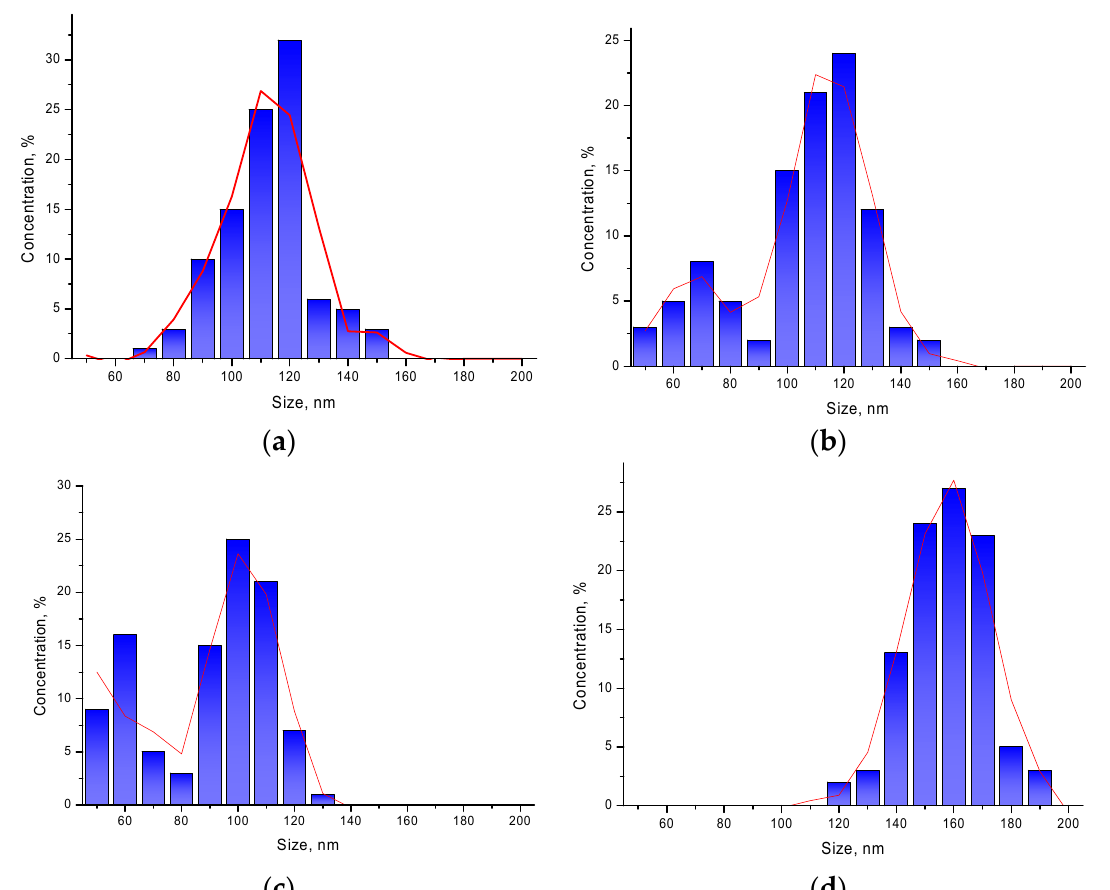
Figure 2. Diagrams of nanoparticle size distribution depending on the dopant concentration: ( a ) FeCeO x nanoparticles; ( b ) 0.9FeCeO x + 0.1Nb 2 O 5 nanoparticles; ( c ) 0.8FeCeO x + 0.2 Nb 2 O 5 nanoparticles; and ( d ) 0.7FeCeO x + 0.3 Nb 2 O 5 nanoparticles.